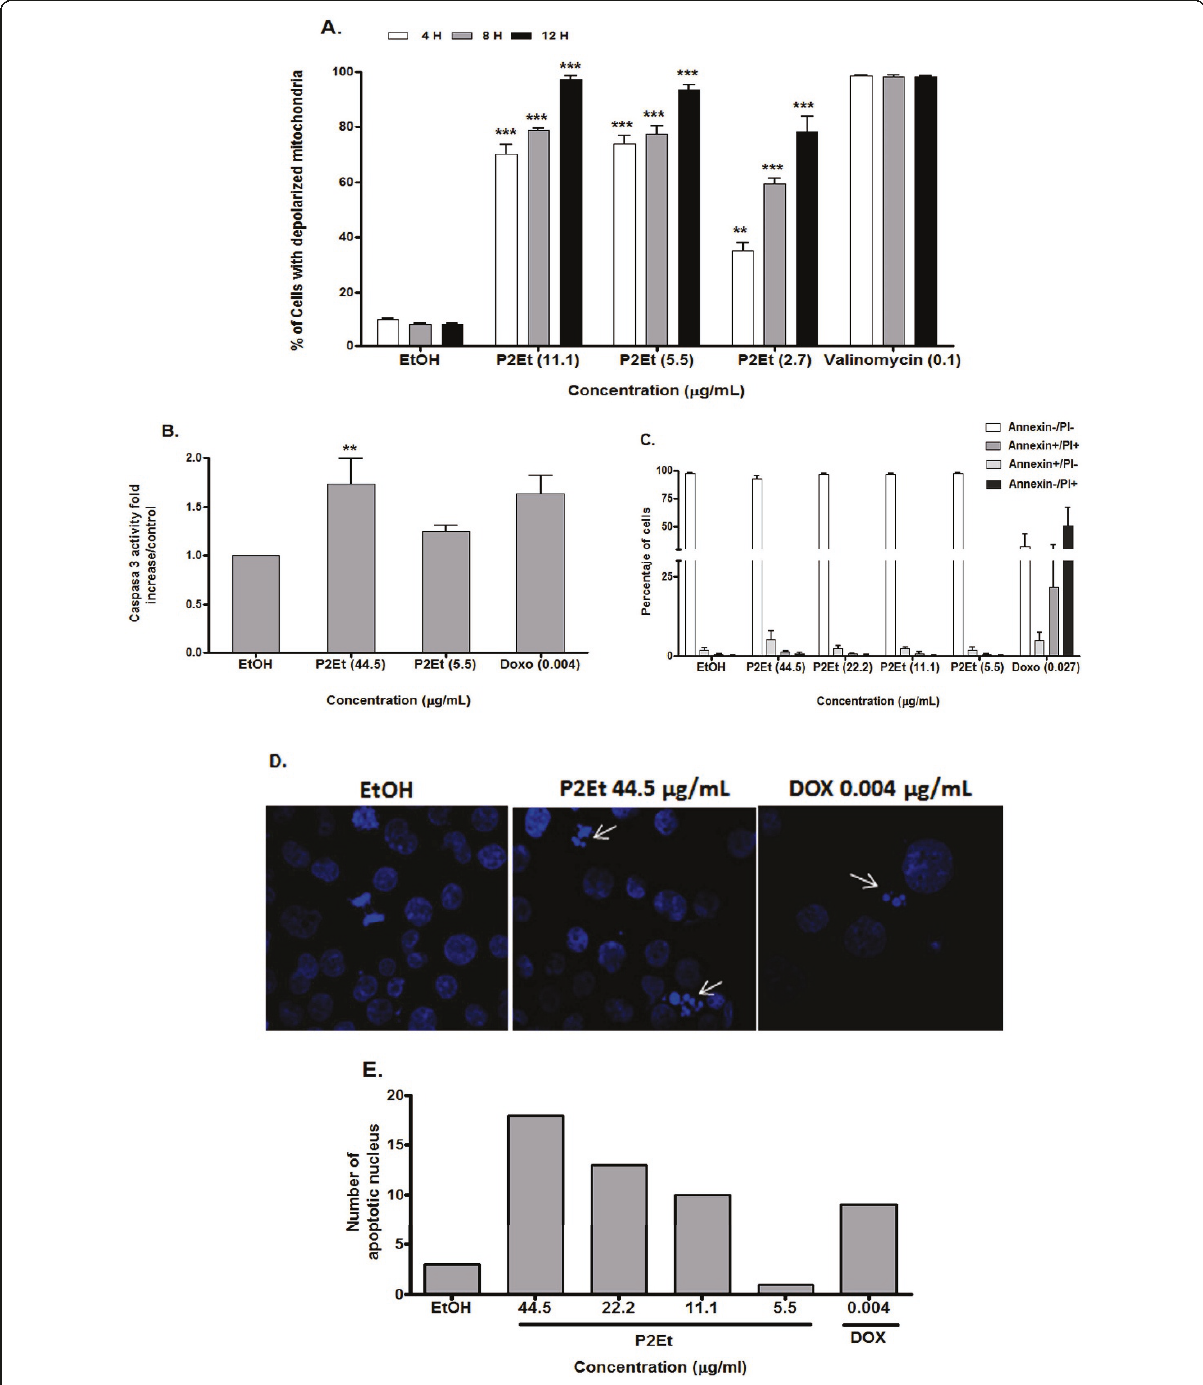
Figure 3 P2Et fraction induction of MMP loss, activation of caspase 3 and DNA fragmentation . (A) K562 cells treated with the P2Et fraction for 4, 8 or 12 h, stained with JC-1 and analyzed by flow cytometry. Ethanol was used as negative and valinomycin as positive controls (*** p < 0.001). (B) Caspase 3 activity was measured using the enzyme-linked immunosorbent assay (ELISA) after cell treatment with the P2Et fraction or doxorubicin (positive control) for 48 h (** p < 0.005). (C) PS externalization was estimated in K562 cells using flow cytometry after cell treatment for 48 h with the P2Et fraction, doxorubicin (positive control) or ethanol (negative control). (D) DNA was stained with 4 ’ ,6-diamidino-2- phenylindole (DAPI) after cell treatment for 48 h. Apoptotic cells or fragmented nuclei were observed under fluorescent microscope (40X). (E) Apoptotic cells were estimated by random observation in six fields and by counting cells with strong fluorescence or fragmented